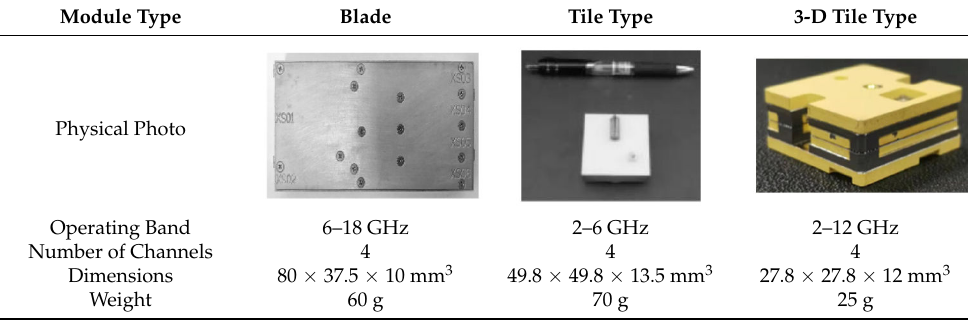
Table 2. Comparison of the dimensions of our model with those of other T/R